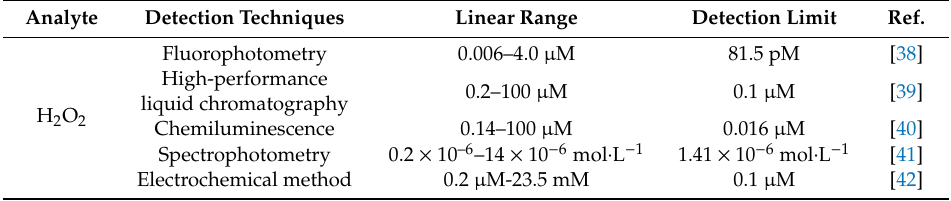
Table 1. Comparison of performance of di ff erent techniques for detecting H 2 O